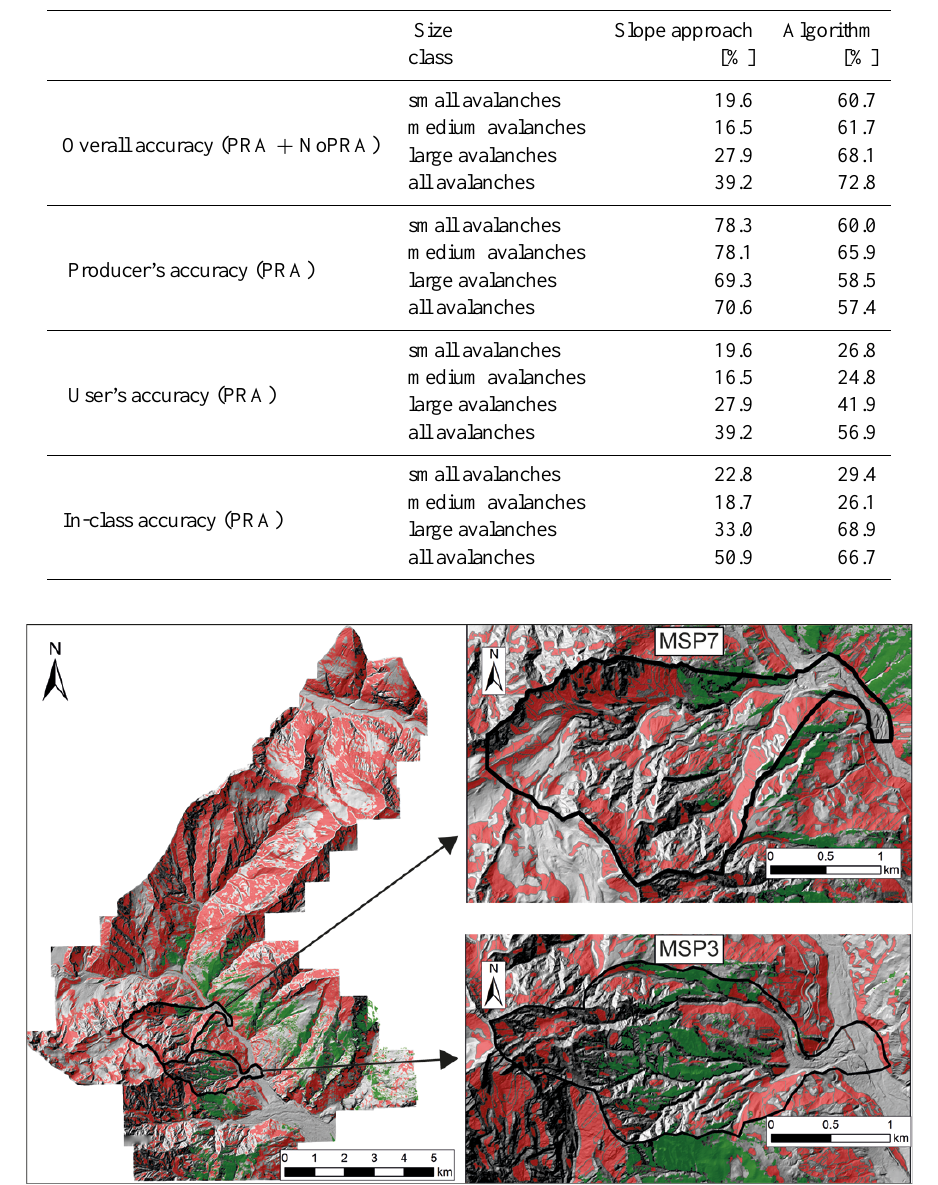
Fig. 10. The identified PRA (red) and the classified forest patches (green). A more detailed view of the results is given for the MSPs 3 and 7